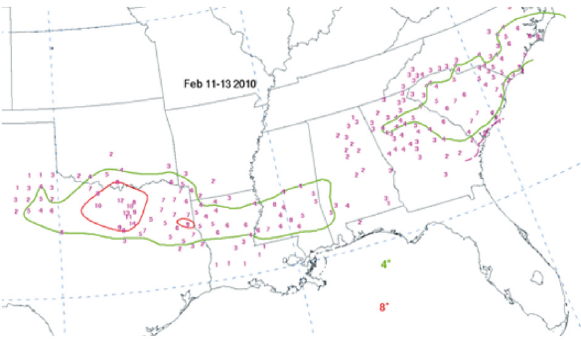
Figure 2: Snowfall accumulation totals (in inches), February 11–13, 2010, from WPC NCEP